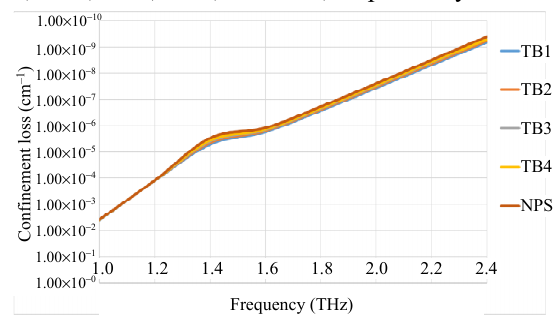
Fig. 10 CL of the proposed sensor for various tuberculosis-infected samples versus frequency.